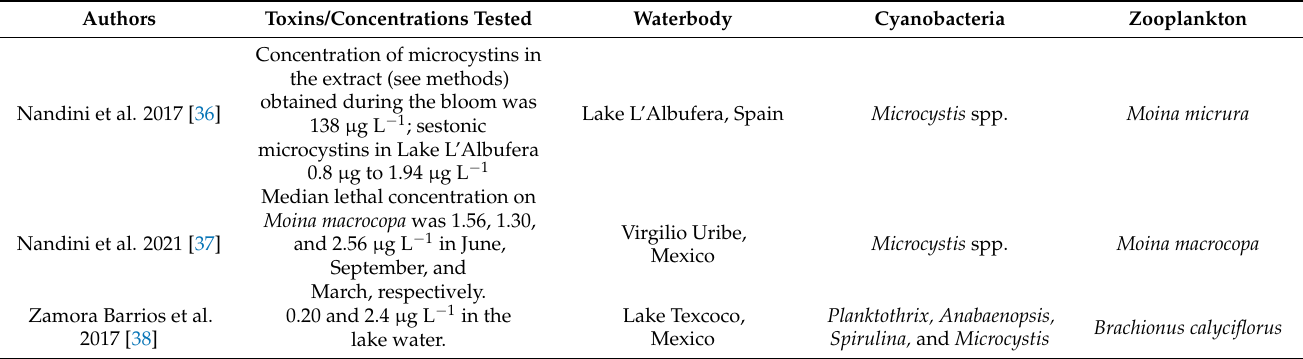
Table 3. Selected data on the effects of cyanobacteria/cyanotoxins on zooplankton based on laboratory and field